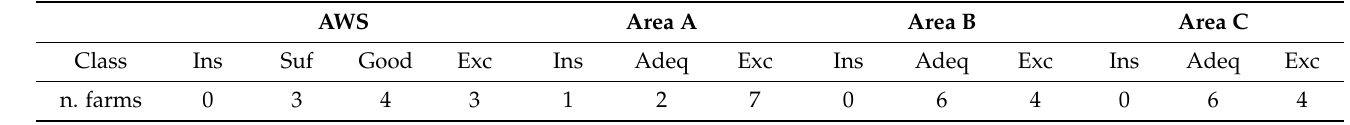
Table 4. Distribution of farms (n) in classes according to AWS and the individual area score. AWS Area A Area B Area C